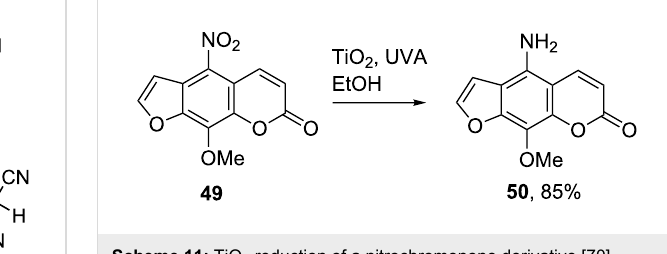
Scheme 11: TiO 2 reduction of a nitrochromenone derivative